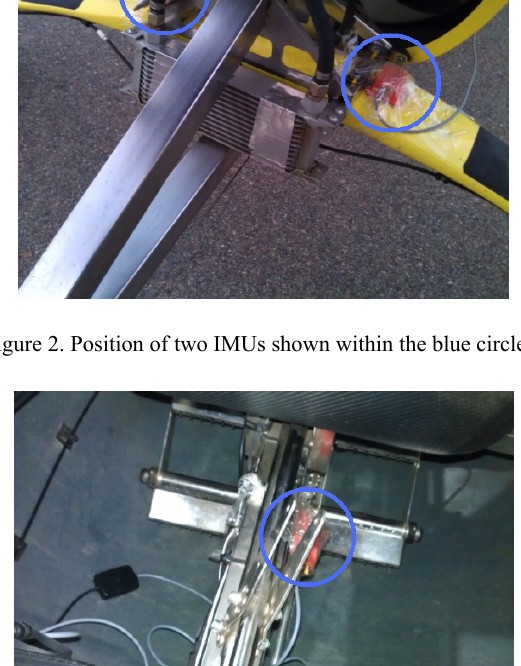
Table 1. Typical vibrational frequencies induced by motor, propeller and rotor